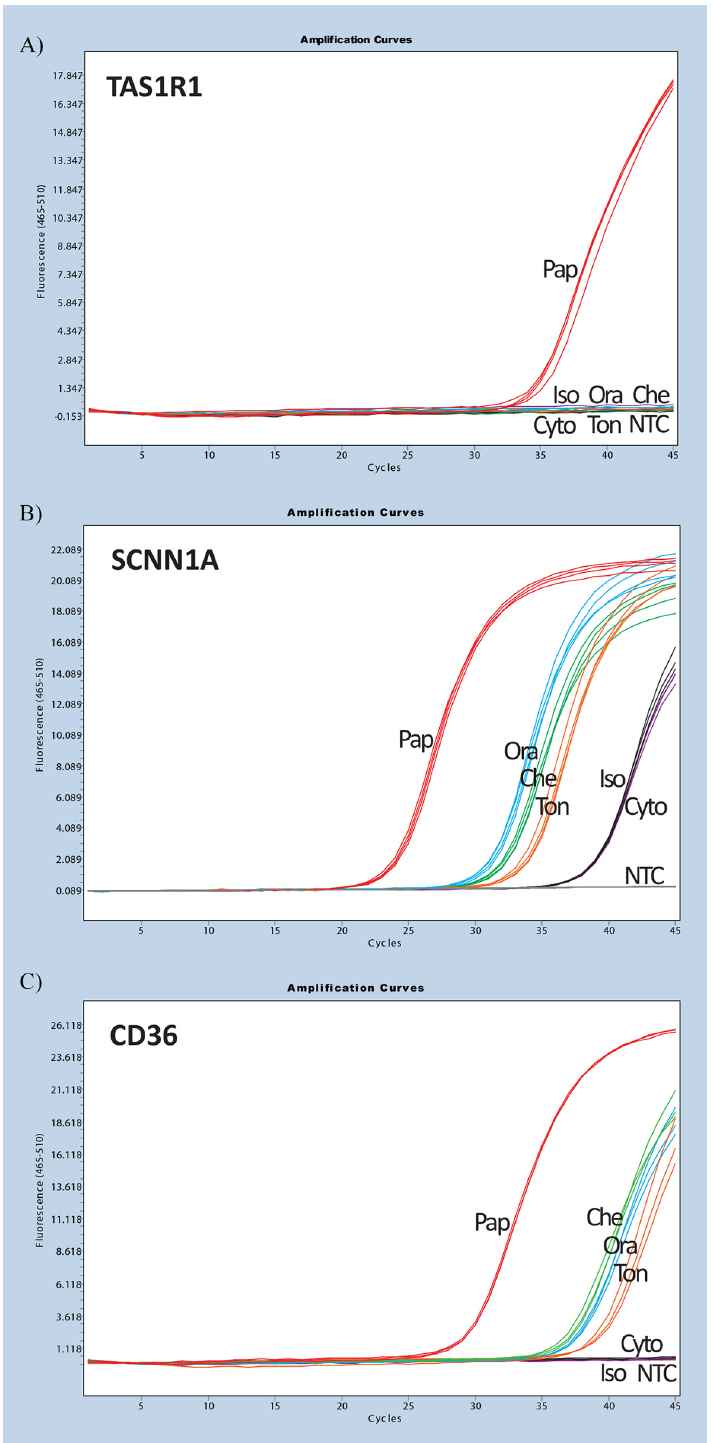
Fig 2. Representative Lightcycler 480 amplification profiles of taste genes using the different collection techniques. Pap — Papillae biopsy (red), Che — Cheek saliva (Green), Ton — Tongue saliva (orange), Ora — Oragene kit (blue), Iso — Isohelix brush (black), Cyto — Livibrush cytobrush (purple), NTC — no template control (grey).